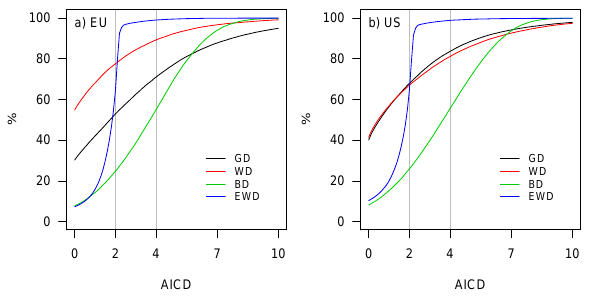
Fig. 7. AICD frequencies (CRU data set): percentages of all grid points and months a distribution yields AICD smaller or equal than a given value for (a) the European region and (b) the contiguous United States. AIC comparison with GD, WD, BD and EWD.